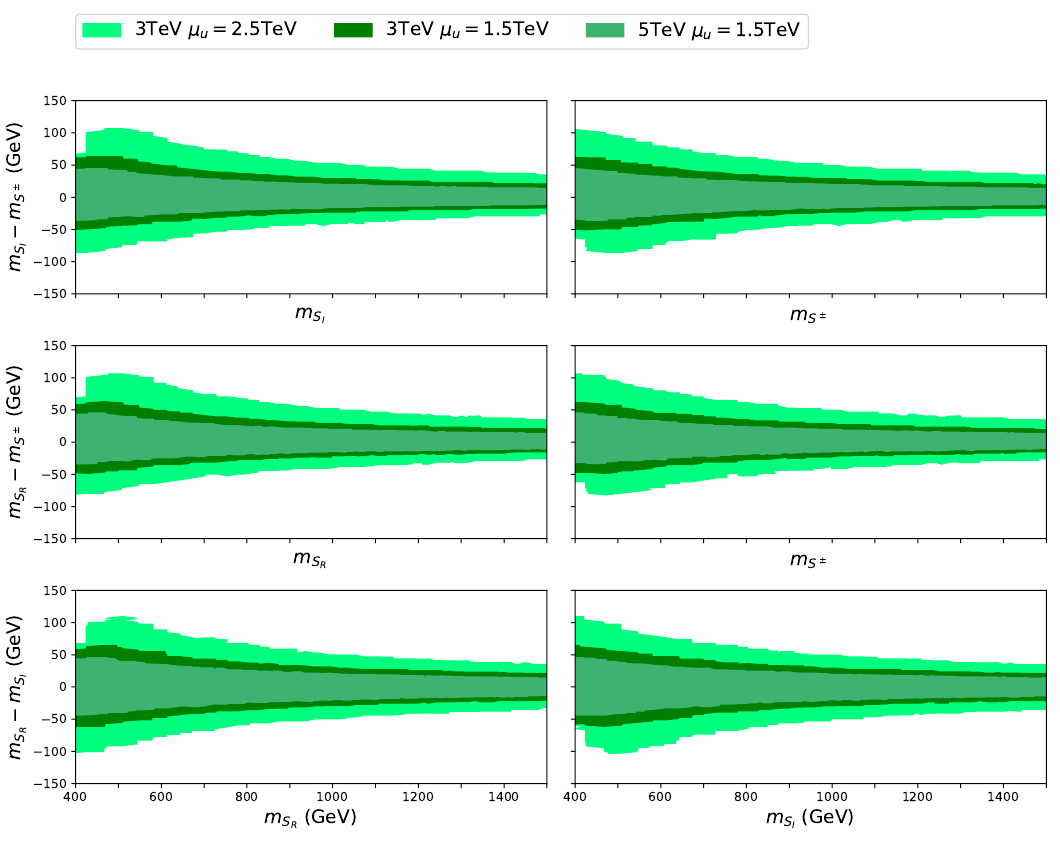
Figure 1 . Theoretical constraints on the mass splittings, as functions of the scalar masses. The different coloured regions correspond to imposing RG stability up to an UV mass scale of 3 or 5 TeV, and imposing perturbative unitarity conditions above 2.5 TeV or 1.5